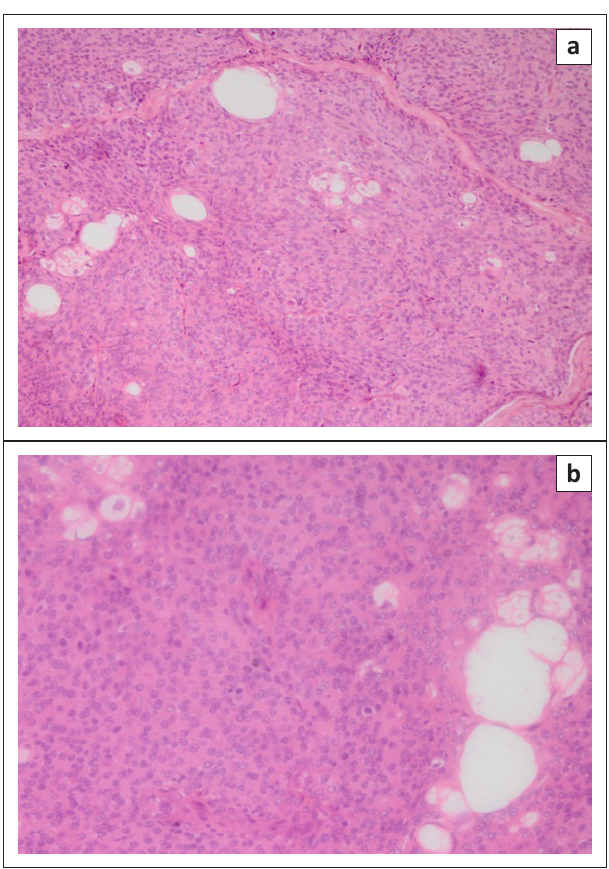
FIGURE 3: Adenocarcinoma of the sebaceous gland showing solid pattern with mitotic figures Hematoxylin and Eosin staining in (a) 20x and (b)